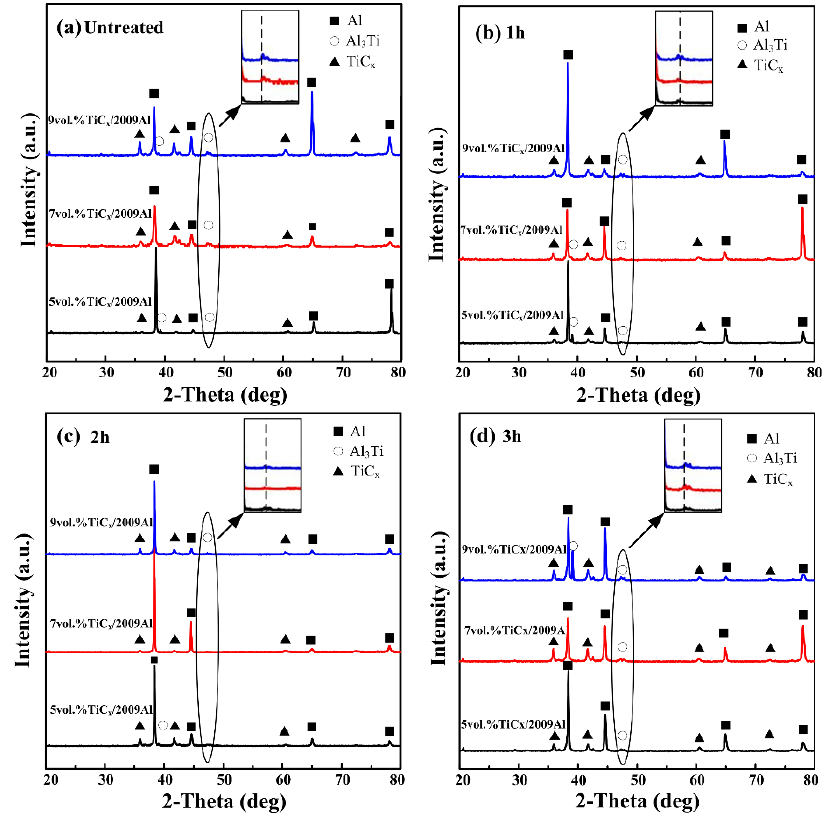
Figure 2. X-ray diffractometry (XRD) patterns of the nano-sized TiC x /2009Al composites prepared by using ( a ) untreated CNTs and CNTs milled for ( b ) 1 h; ( c ) 2 h and ( d ) 3 h as the carbon source.